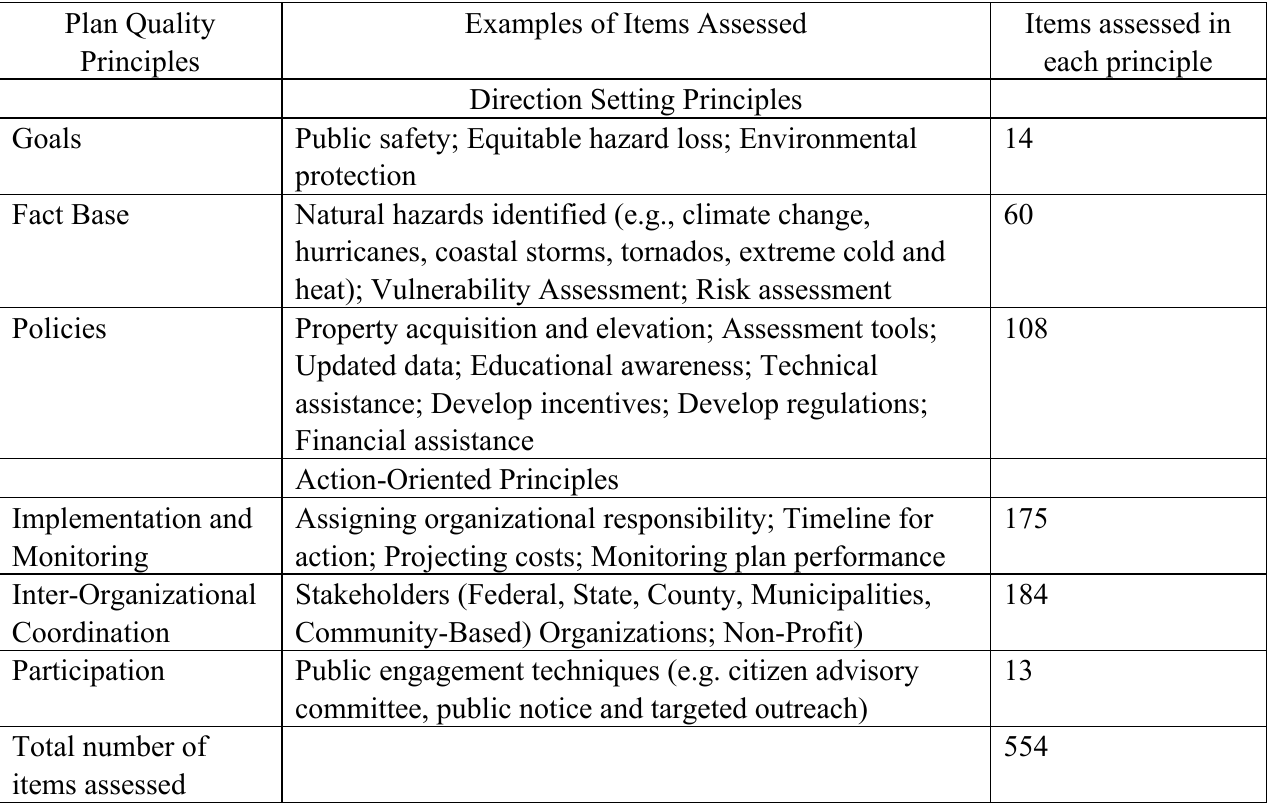
Table 1. Plan quality principles and items